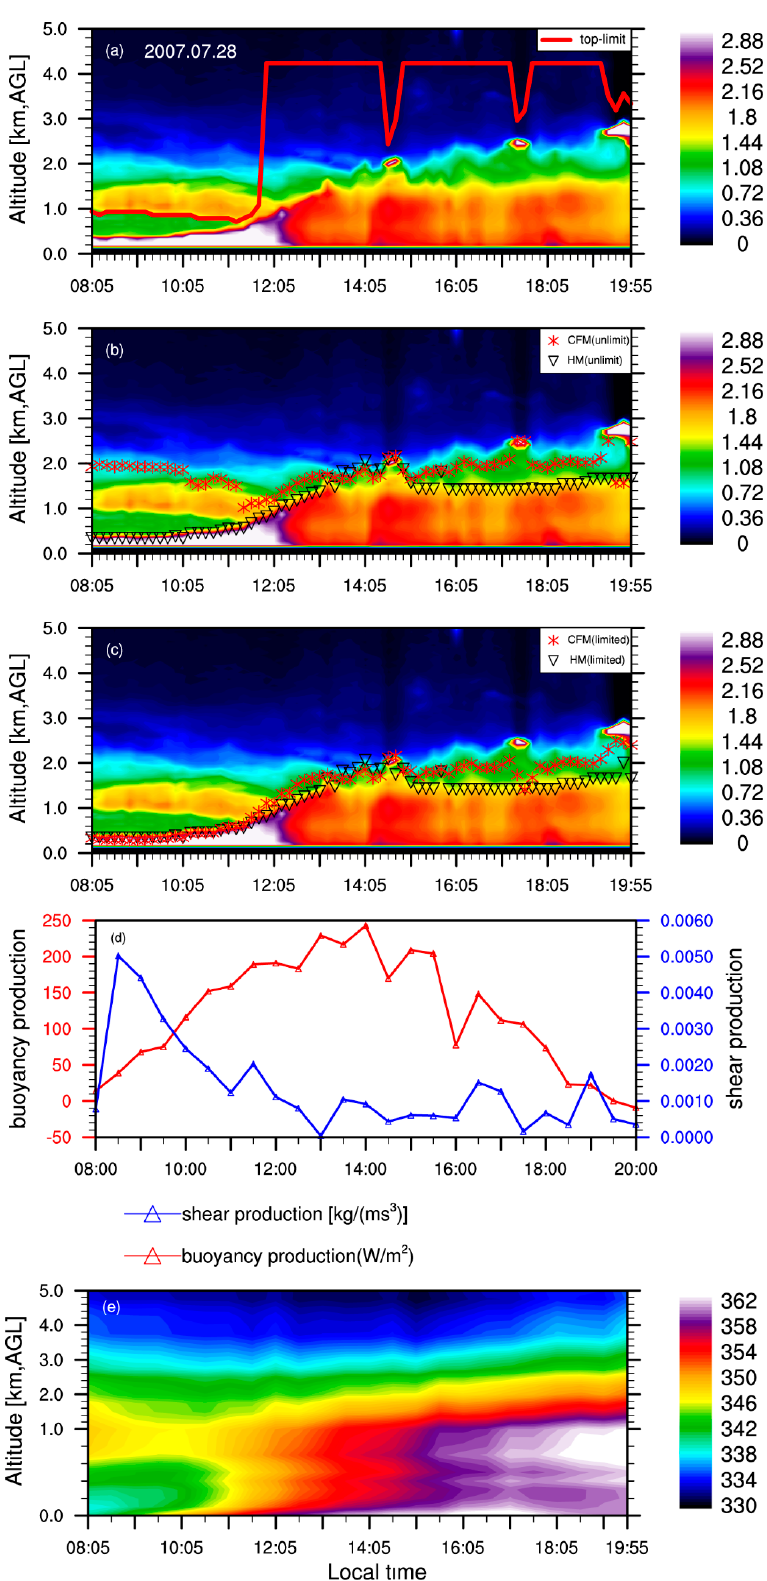
Figure 9. Lidar measurements of ABLH over SACOL on 28 July 2007. ( a ) Time-height cross-section of the NRB, red solid line is the determined top altitude limiter, ( b ) ABLH determined directly from the HM and CFM, ( c ) ABLH determined from the HM and CFM below the top limiter. ( d ) Diurnal cycles of buoyancy production and shear production for ground-layer turbulent kinetic energy (TKE), ( e ) time-height cross-section of equivalent potential temperature ( θ e